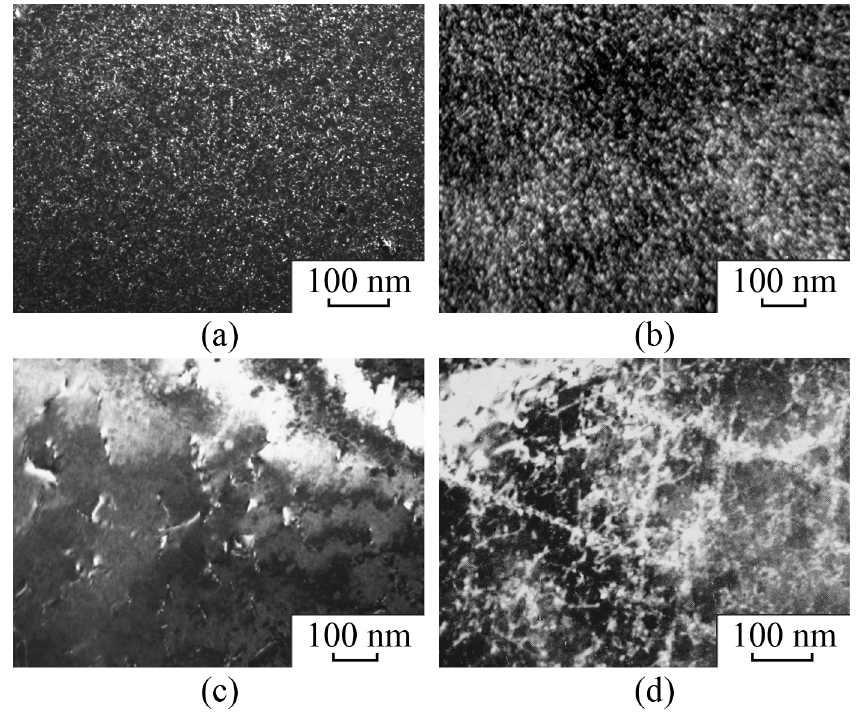
Figure 13. Dark-field images taken in the matrix reflection of the alloys after aging at 923 K for 3 h. ( a ) Fe 63.5 Ni 33.4 Ti 3.1 , ( b ) Fe 55 Ni 36 Al 9 , ( c ) Fe 62.1 Ni 32.2 Si 5.7 , ( d ) Fe 62.9 Ni 34.9 Zr 2.2 .